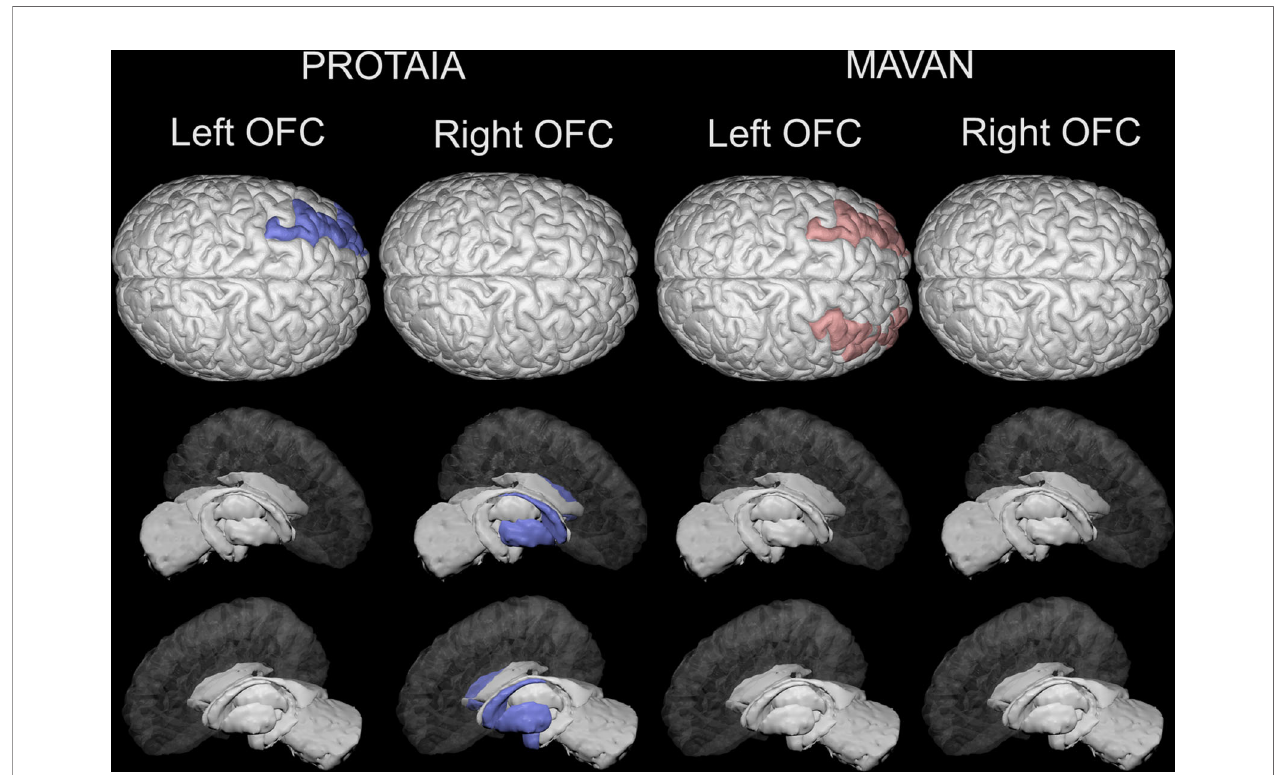
FIGURE 2 | Brain areas depicting statistically signi fi cant differences in resting-state functional connectivity (rsFC) with the left and right orbital frontal cortex between SGA and controls in the PROTAIA and MAVAN cohorts. Blue color (left DL-PFC, left amygdala and right and left dorsal striatum) represents lower rsFC in SGA versus Controls. Red color (right and left DL-PFC) represents higher rsFC in SGA versus